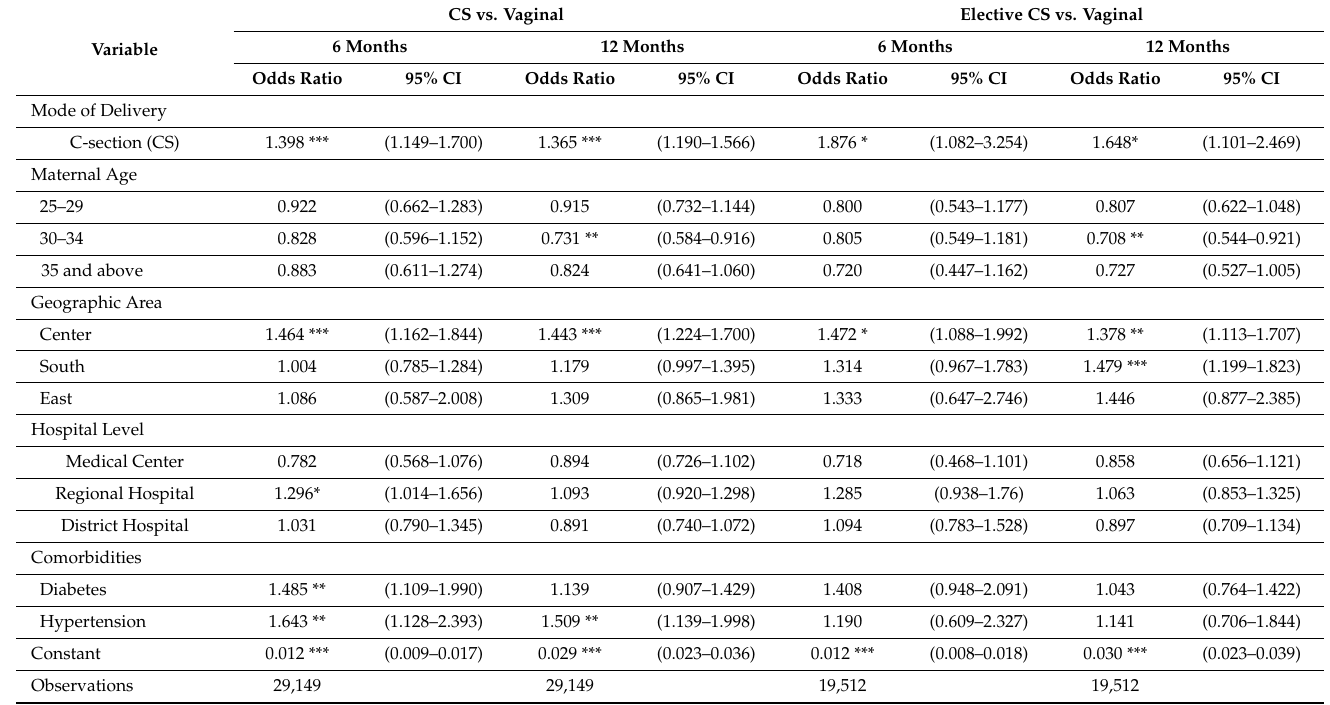
Table 2. Logistic Regressions for Women without History of Depression.